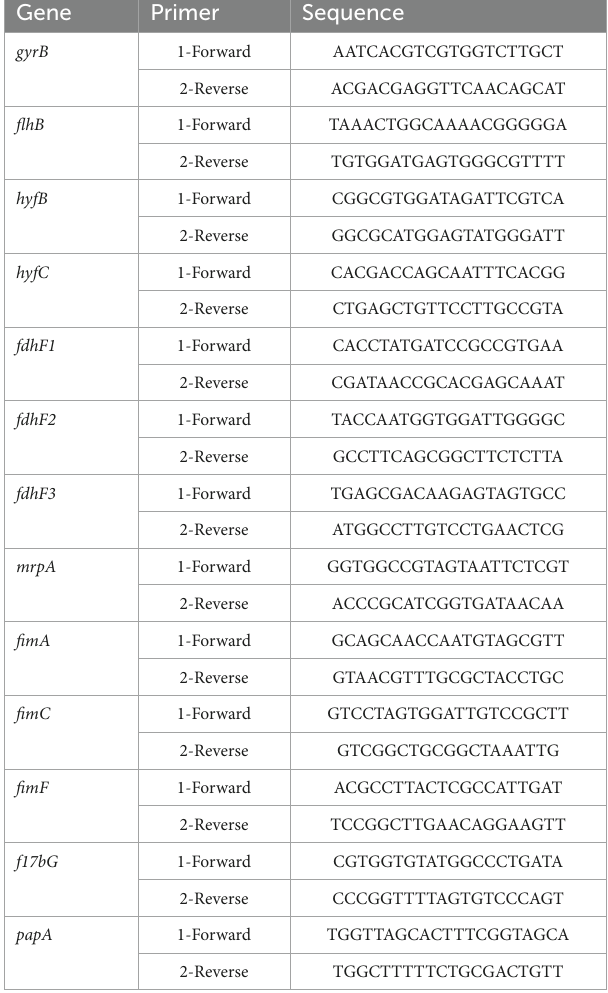
TABLE 1 Sequences of the primers used for RT–qPCR validation in this study.